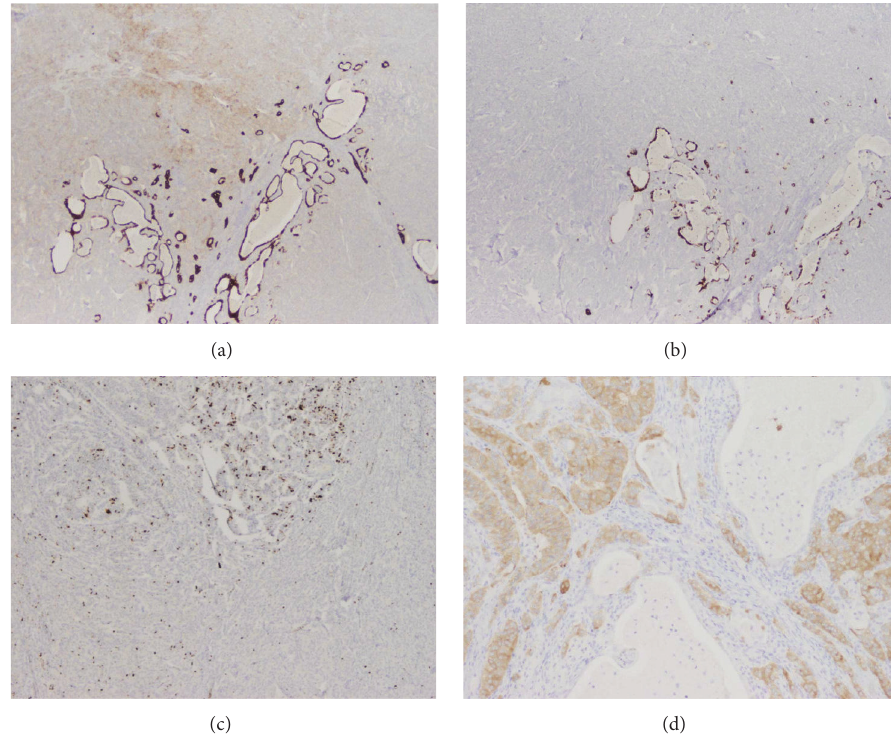
Figure 4: Metastasis to the perigastric lymph nodes: (a) CK7 and (b) CK20 images highlight differential staining with strong staining in the glandular component but lack of staining in the neuroendocrine component (a and b, 40x). (c) The glandular elements have a higher proliferation rate than the neuroendocrine on Ki-67 (MIB, 40x). (d) Synaptophysin is diffusely positive in the neuroendocrine but negative in the glandular foci (100x); chromogranin stain had a similar